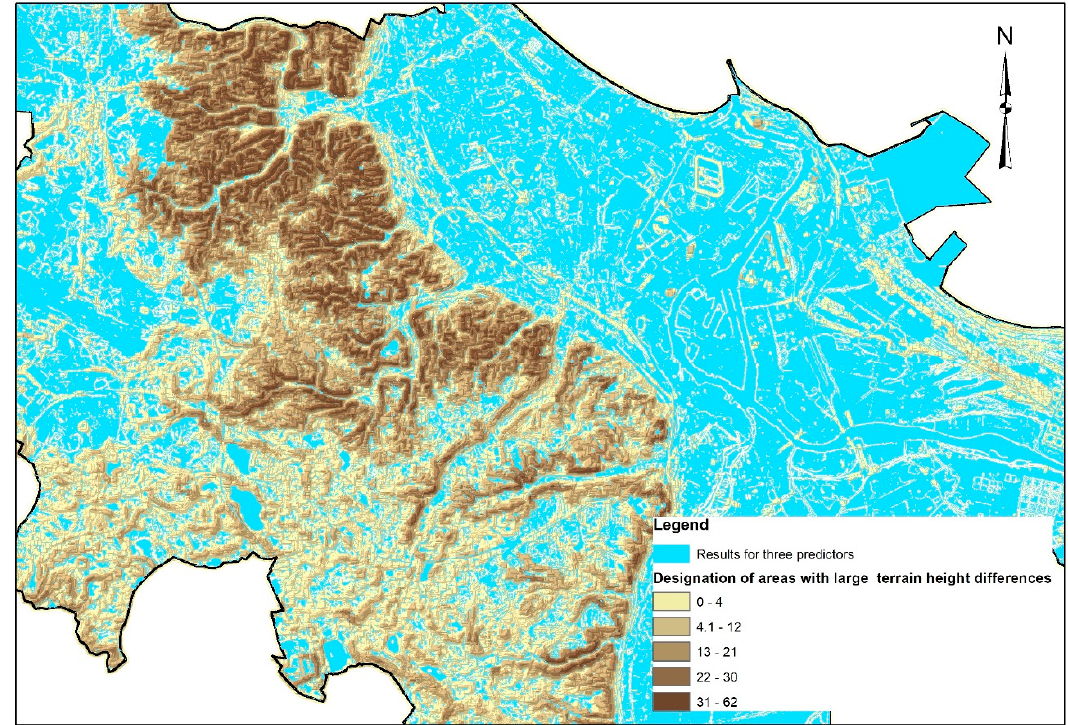
Figure 9. Overlaid results for three predictors